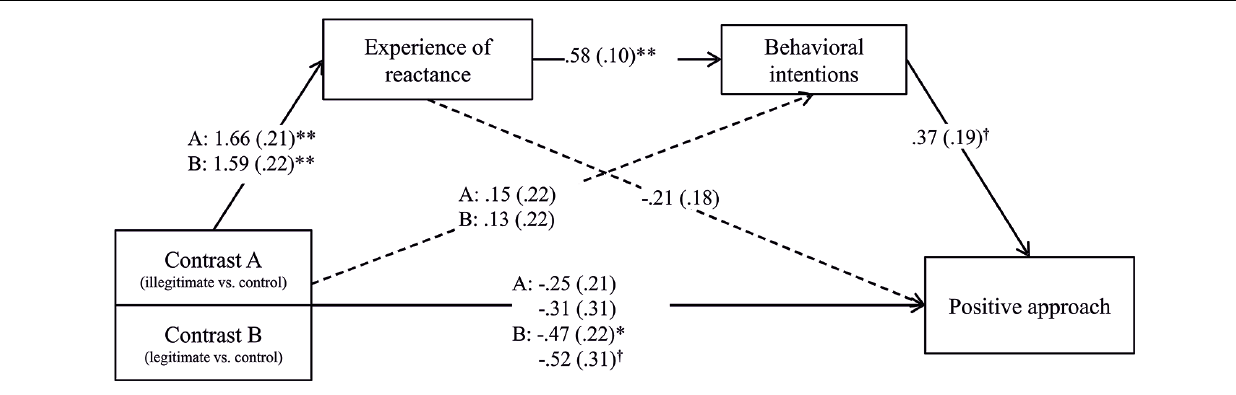
FIGURE 3 | The effect of freedom restrictions on negative approach (anger) via experience of reactance and behavioral intentions. † p < 0.10, ∗ p < 0.05, ∗∗ p <